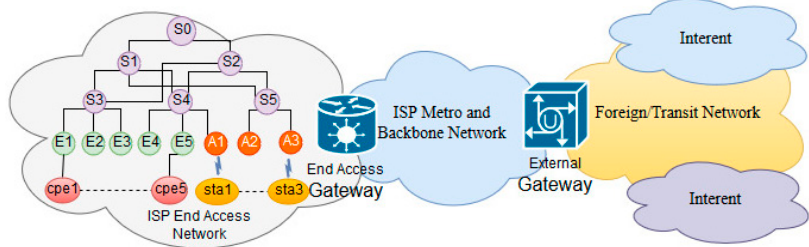
Figure 2. End access network in the ISP (Internet Service Provider) network infrastructure.